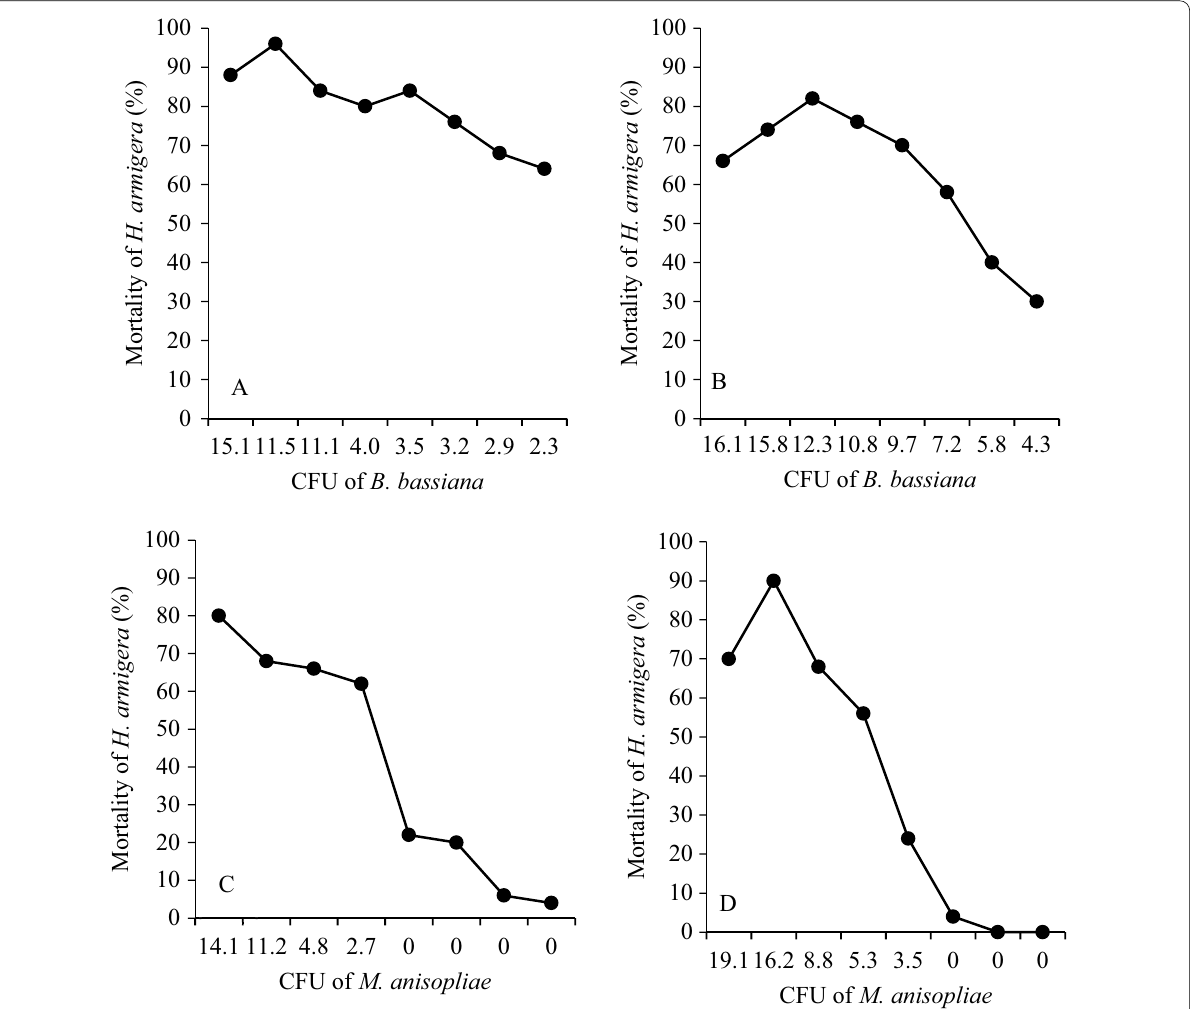
Fig. 2 Correlation between the number of colony-forming units (CFUs) of Beauveria bassiana in A 2018 and B 2019 and the mortality of Helicoverpa armigera. Correlation between the number of CFUs of Metarhizium anisopliae in C 2018 and D 2019 and the mortality of H.